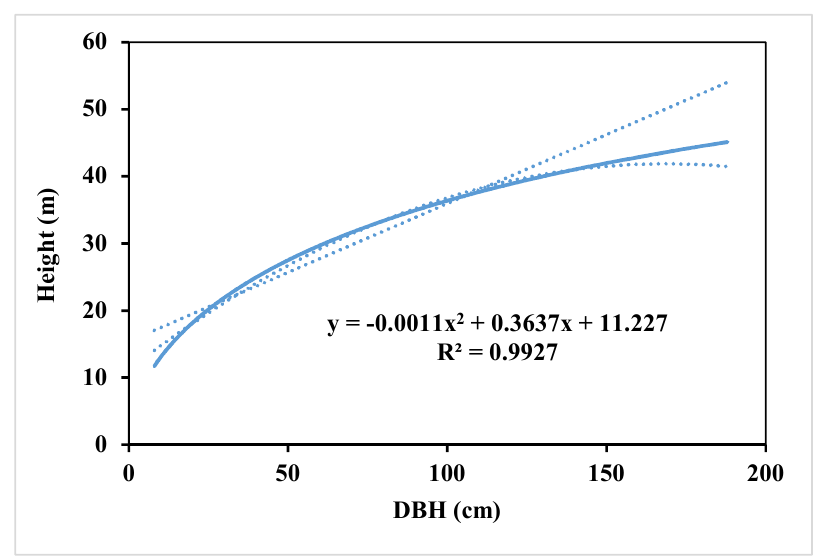
Figure 5. Diameter-predicted heights of the selected model (Weibull).